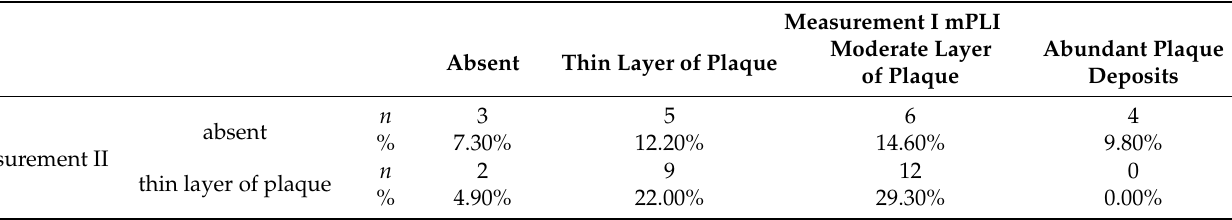
Table 2. Plaque deposit—mPLI before (measurement I) and after treatment (measurement II) with a bioactive healing abutment containing